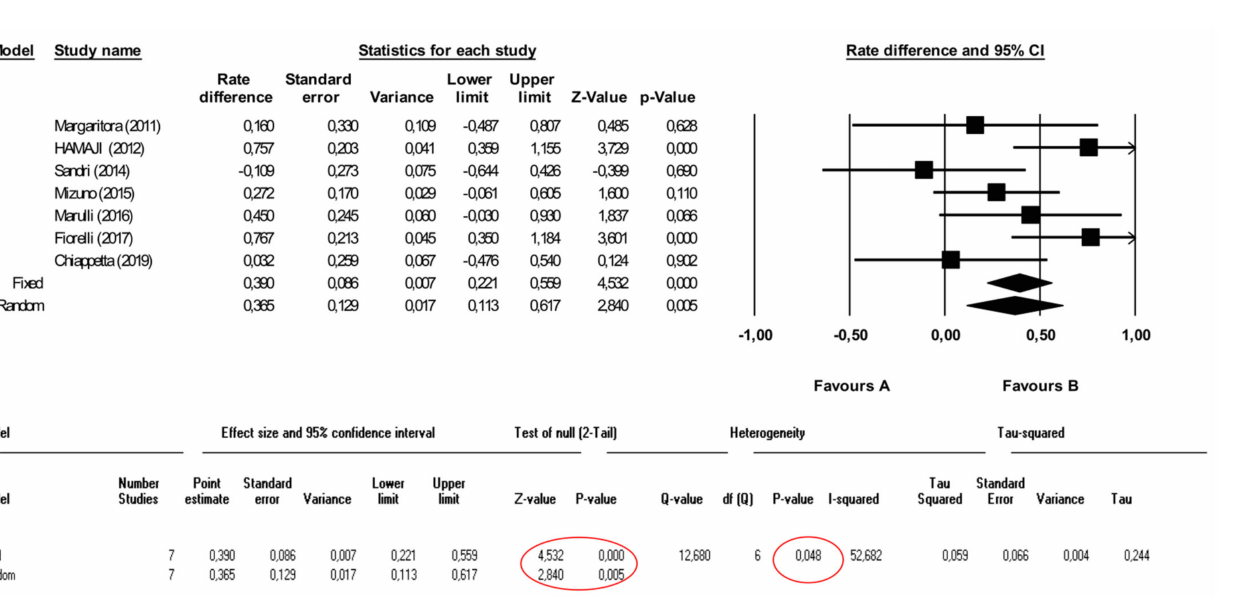
Figure 2. Forest plot showing the impact of surgery versus other treatments on overall